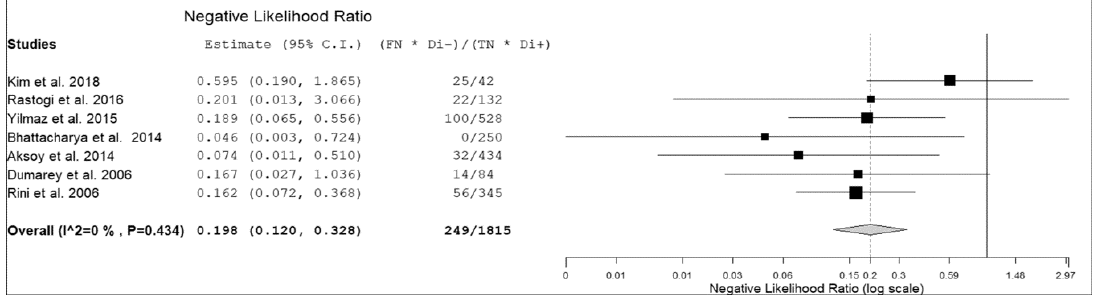
Figure 4. Forest plot of individual studies and pooled negative likelihood ratio of 18 F-FDG-WBC PET or PET/CT in patients with suspicious infectious diseases, including 95% confidence interval (95%CI). The size of the squares indicates the weight of each study.